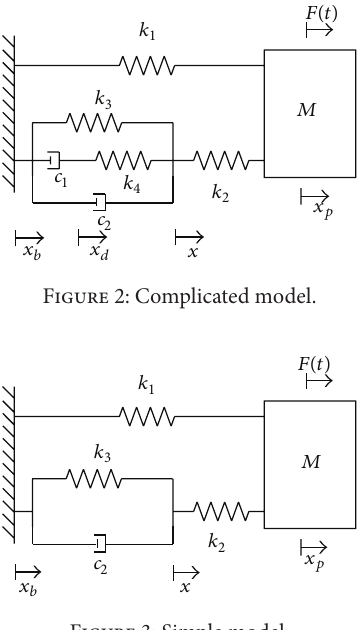
Figure 3: Simple model.